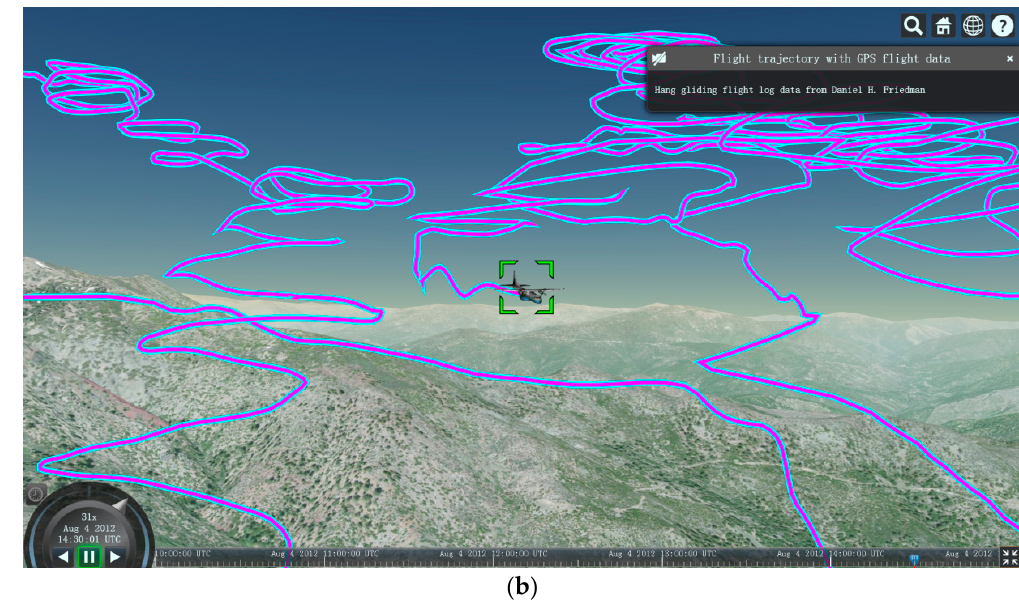
Figure 5. Example of using time tags to animate a flight trajectory with time-varying positions. Two figures compare the flight trajectory and the position of the aircraft at the moments of 13:39:31 ( a ) and 14:30:01 ( b ).